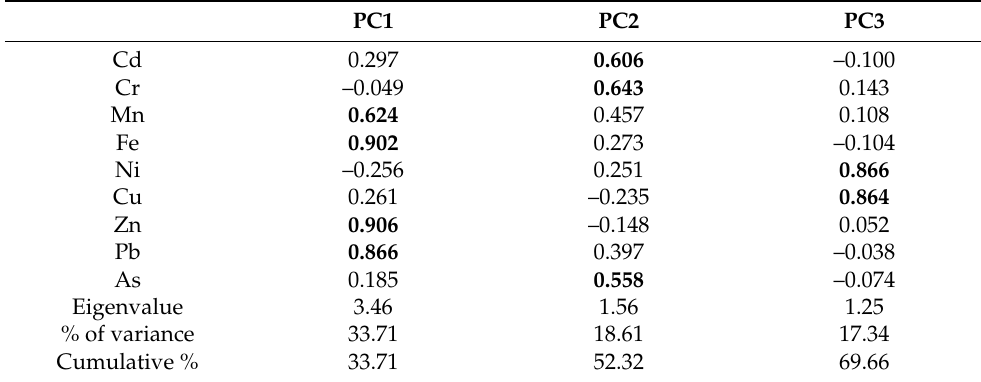
Table 5. Principal component analysis matrix of heavy metals in